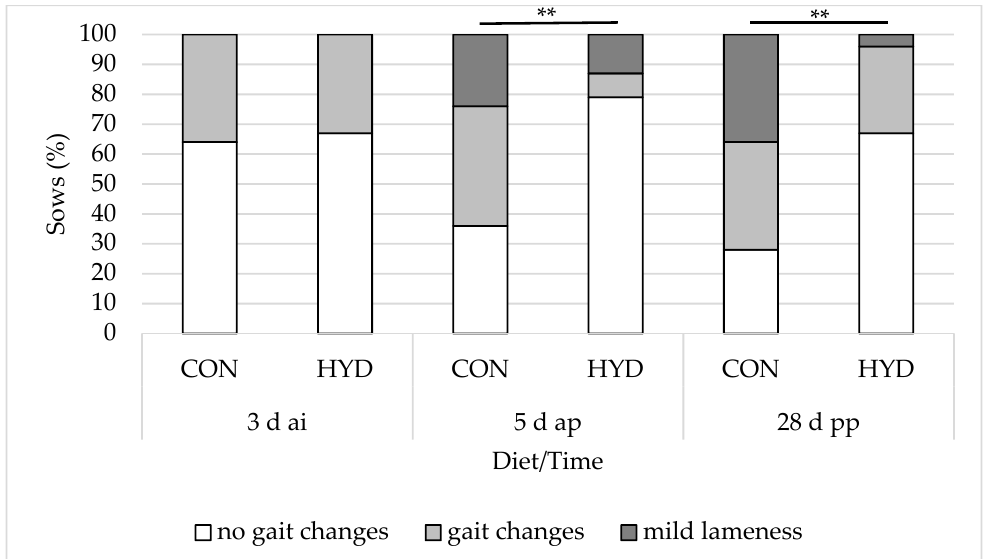
Figure 3. Effect of dietary vitamin D source on prevalence (%) of leg swelling (carpal/tarsal joints) of sows. CON, 50 μ g/kg vitamin D 3 ( n = 25); HYD, 50 μ g/kg 25-OHD 3 ( n = 24).